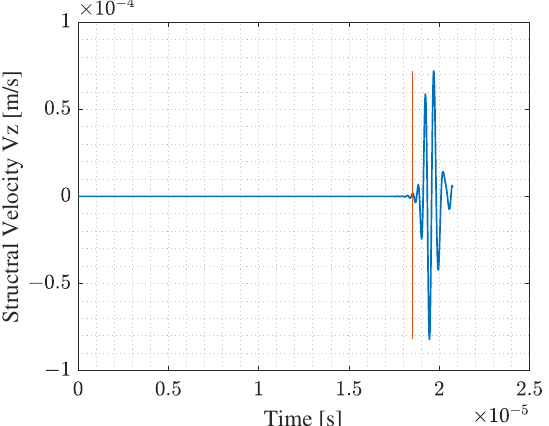
Figure 13. Computed structural velocity (Vz) history at bolt end/silicone layer interface.